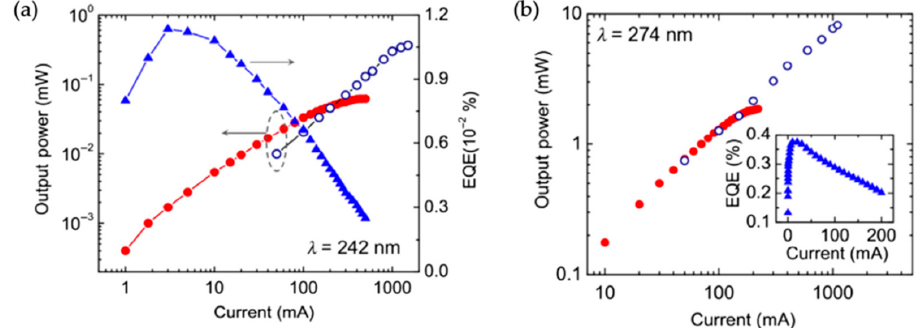
Figure 4. ( a , b ) Light output power and EQE vs. the injection current for AlGaN nanowire tunnel junction deep UV LEDs emitting at 242 and 274 nm, respectively. Device size: 1 mm × 1 mm [32]. Open symbols represent devices under the pulse operation, whereas filled symbols denote devices under the continuous-wave (CW) operation.